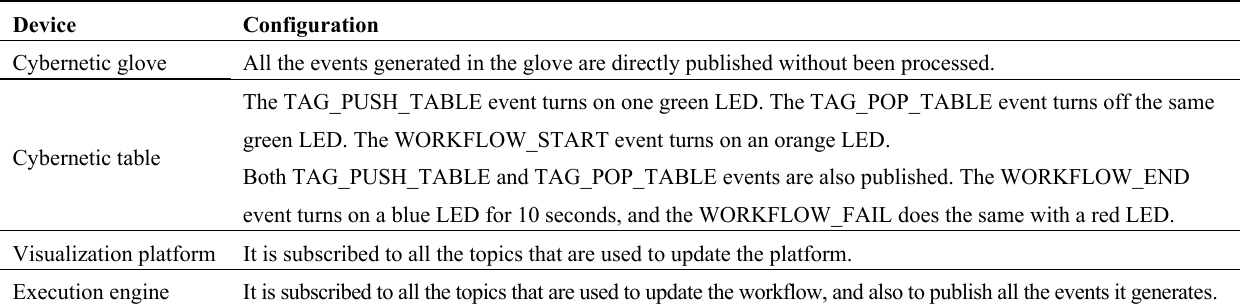
Table 4. Devices’